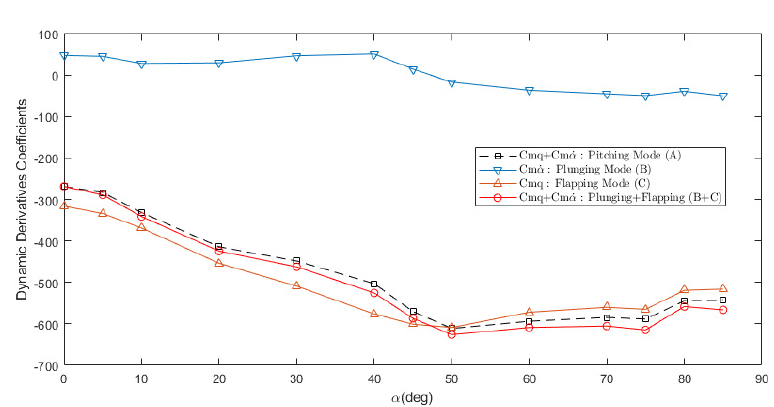
Figure 16. Comparison of combined dynamic stability derivatives of forced plunging and forced pitching simple harmonic oscillation.